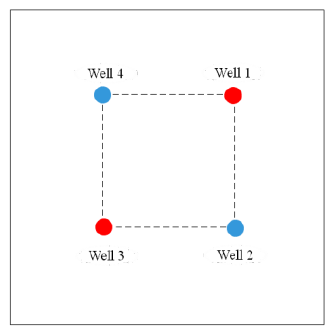
Figure 9. Schematic of the intermittent injection method (modified from [180]).